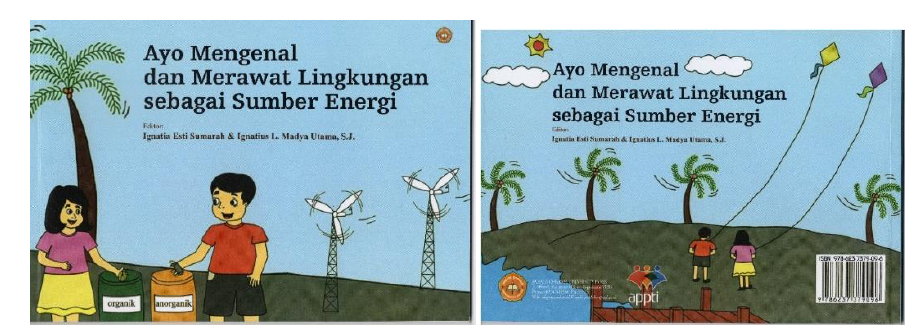
Figure 2 : The front and back covers of the pictorial